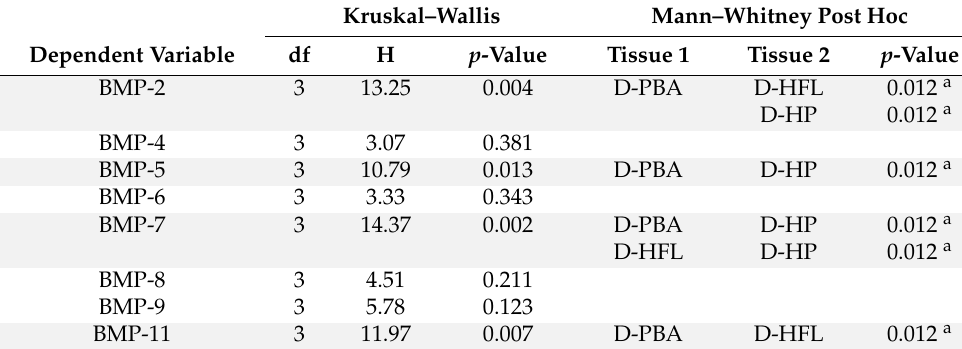
Table 3. Comparison of BMP content between each different